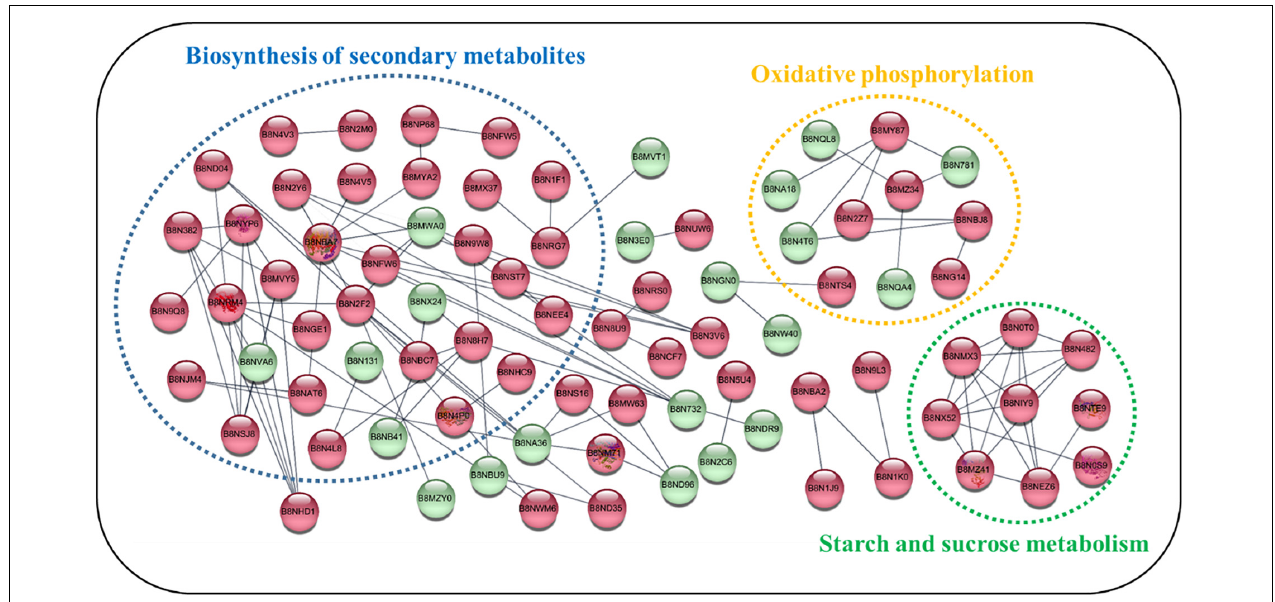
FIGURE 5 | Predicted protein–protein interactions among differentially expressed proteins (DEPs) across metabolic pathways. The STRING database was used to examine proteins that showed increased or decreased expression in A. flavus isolated from natural environments. Each node in the network represents a DEP. The red and green nodes represent up- and down-regulated proteins, respectively. Clusters of interest are indicated by colored labels. The proteins involved in the biosynthesis of secondary metabolites, oxidative phosphorylation, and starch and sucrose metabolism are circled in dotted